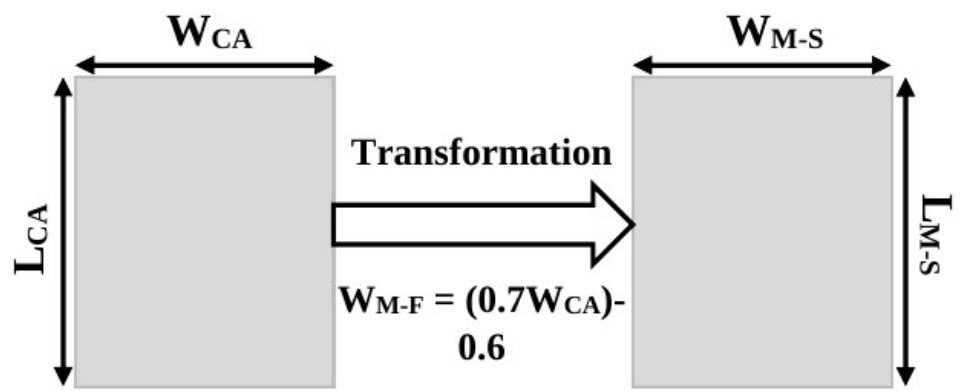
Table 8. Comparison of the proposed method with other approaches in literature.